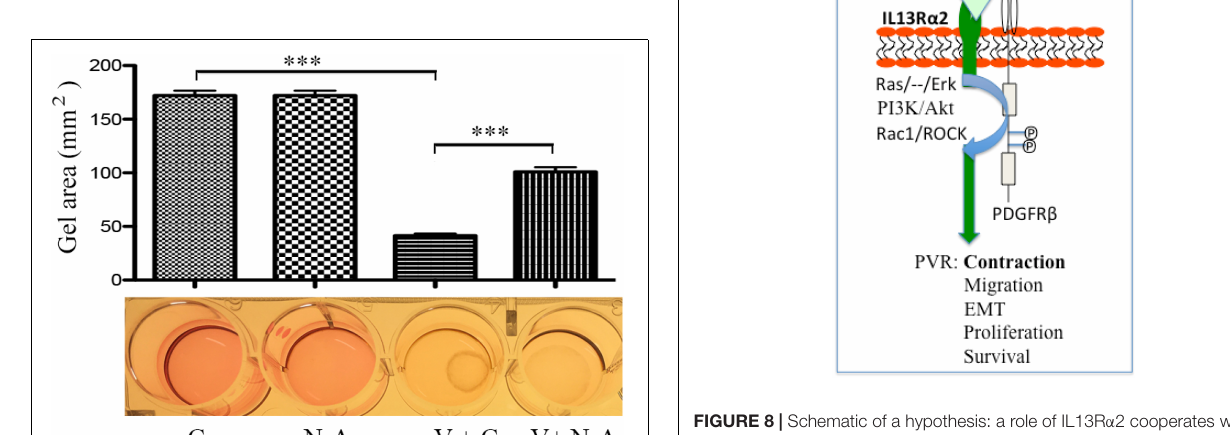
FIGURE 8 | Schematic of a hypothesis: a role of IL13R α 2 cooperates with PDGFR β in the PVR pathogenesis. Based on current literatures (13, 55) IL13R α 2 cooperates with PDGFR β to initiate signaling pathways of Ras/Raf/MEK/ERK, PI3K/Akt, Rac1/ROCK, and thereby enhance cellular responses (survival, proliferation, EMT, migration, and contraction) intrinsic to PVR. ERK, extracellular signal-regulated kinases; PI3K, phosphoinositide 3 kinase; Rac1, Ras-related C3 botulinum toxin substrate 1; ROCK, Rho-associated protein kinase; EMT, epithelial–mesenchymal transition; PVR, proliferative